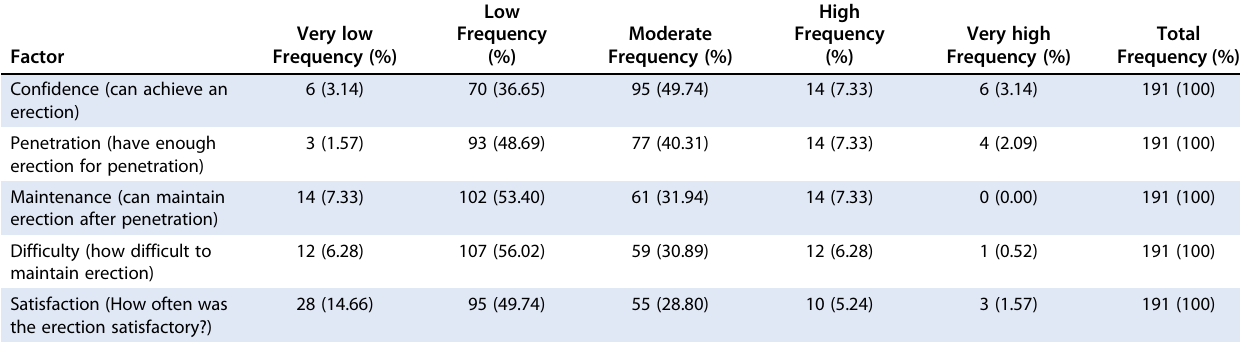
Table 2: Frequency and percentage of different levels of erectile dysfunction